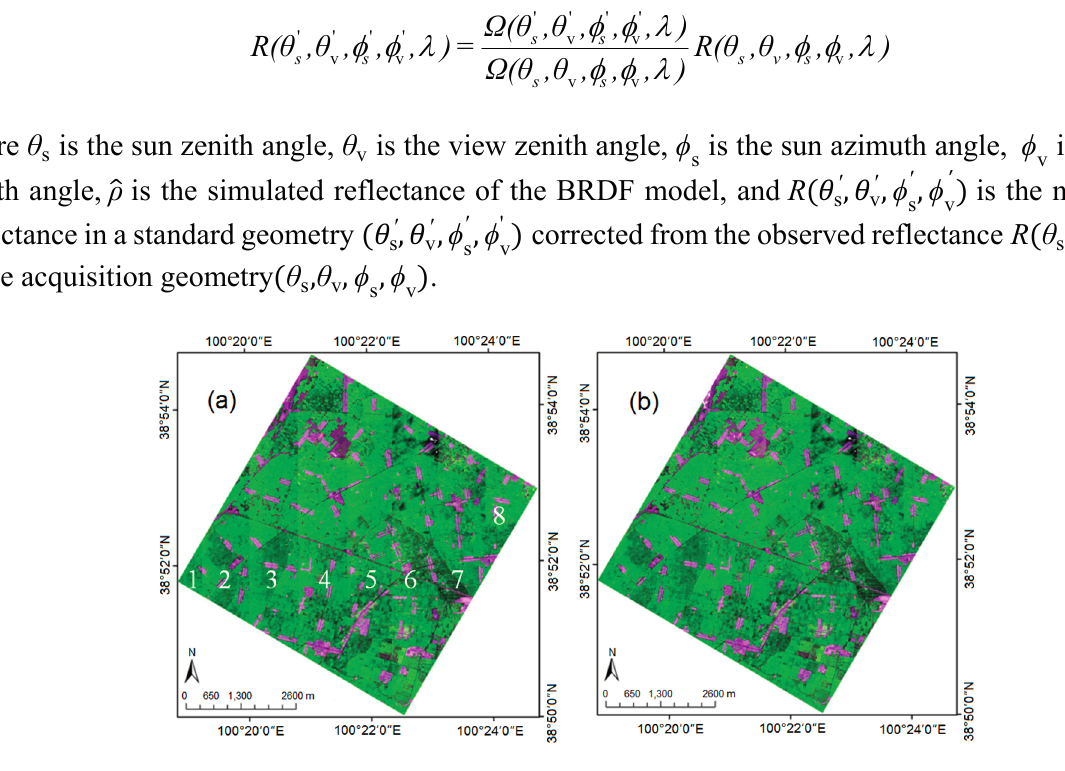
Figure 13. CASI reflectance images. ( a ) is before normalization, the flight lines are indicated by white-colored numbers; ( b ) is after